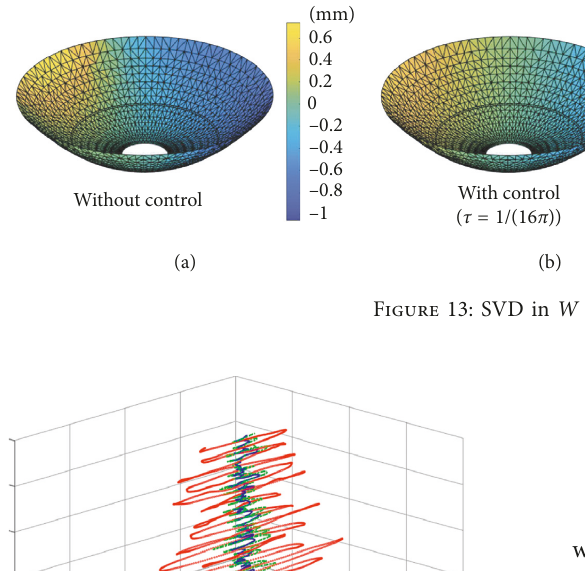
Figure 12: Tensions and longitudinal deformations of the cables. The red curve is the ideal T the CACS; the blue curve is the T i under τ � 1/ ( 160 π ) ; the green curve is the T i under τ � 1/ ( 16 π ) .